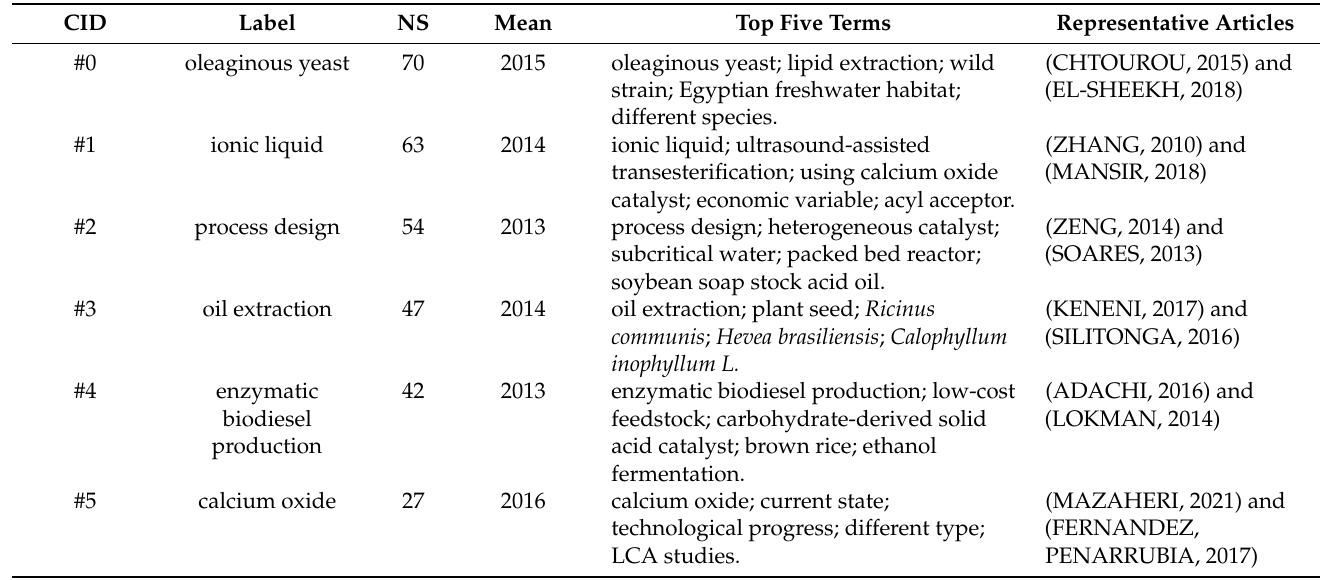
Table 5. Top six co-citation research clusters on raw materials for biodiesel production based on the CiteSpace